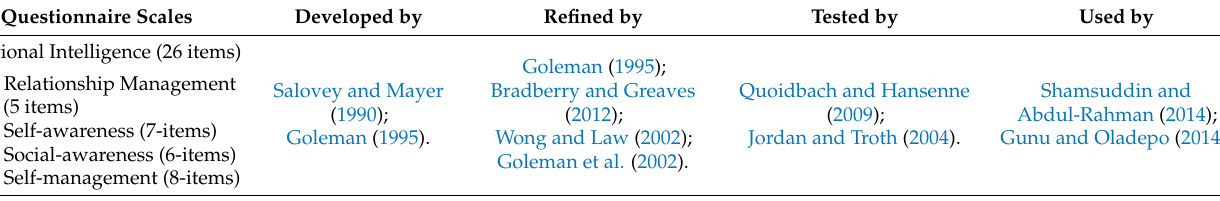
Table 1. Development of the questionnaire (adapted from Salovey and Mayer 1990; Goleman 1995; Zeitz et al. 1997). Questionnaire Scales Developed by Refined by Tested by Used